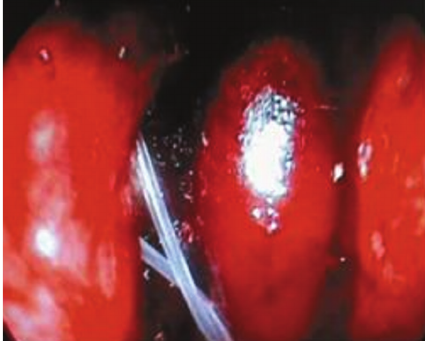
Figure 3: The silicon tubes were left free in the nasal